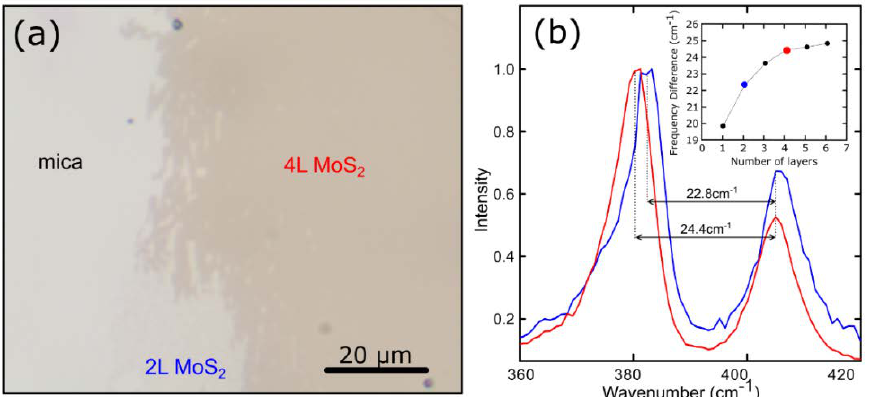
Figure 2. ( a ) Optical image of a large-area MoS 2 on a mica substrate. ( b ) Raman spectra of MoS 2 in different regions of the same sample. The inset displays the relation between the frequency difference of the two peaks and the number of layers of MoS 2 .